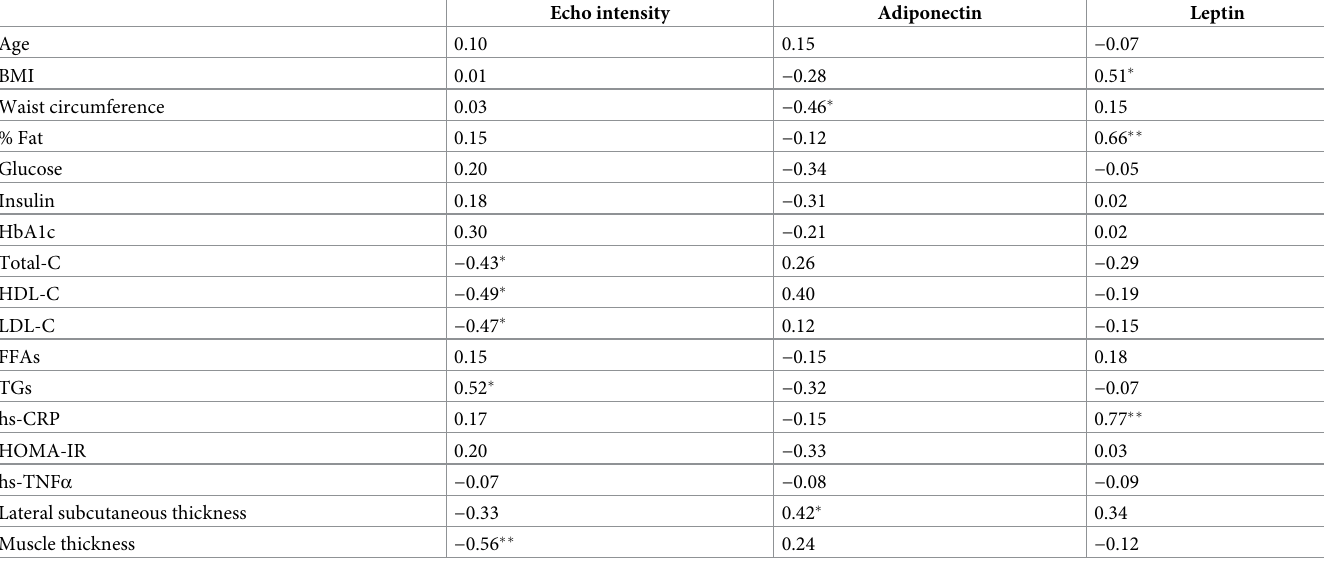
Table 3. Pearson correlation coefficients for echo intensity, adiponectin, and leptin and body composition or biochemical parameter